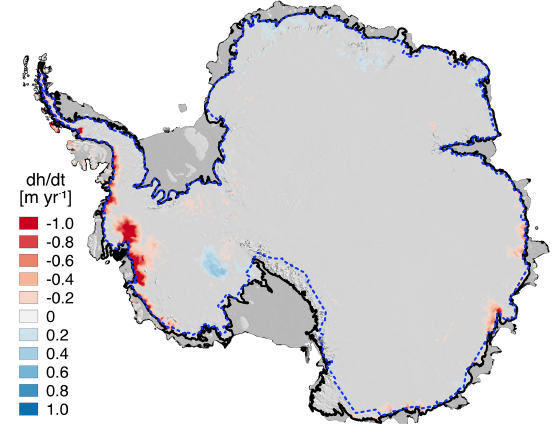
Figure 6. Surface elevation change for the period 2011 to 2015. Flux gate FG2 shown with blue dashed line and GL0 shown with heavy black